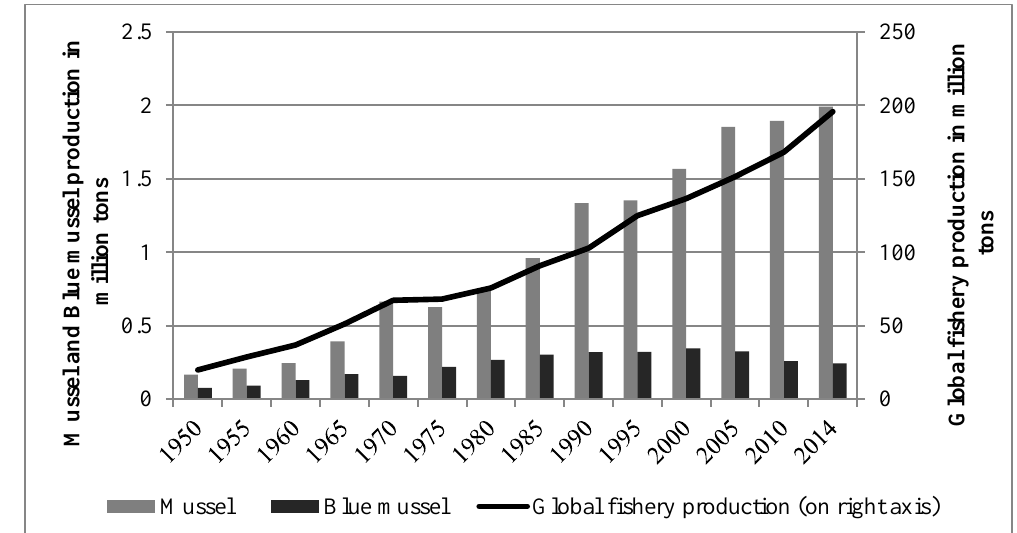
Global fishery production (on right Fig. 3. Fishery and mussel production in the world in 1950‒2014 (Developed by author; FAO data, 2017).